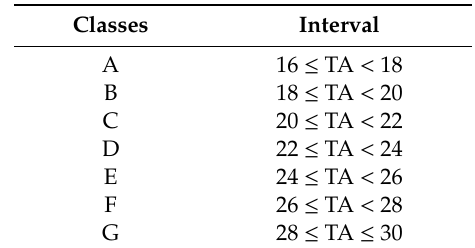
Table 3. List of input variables used for the TA prediction